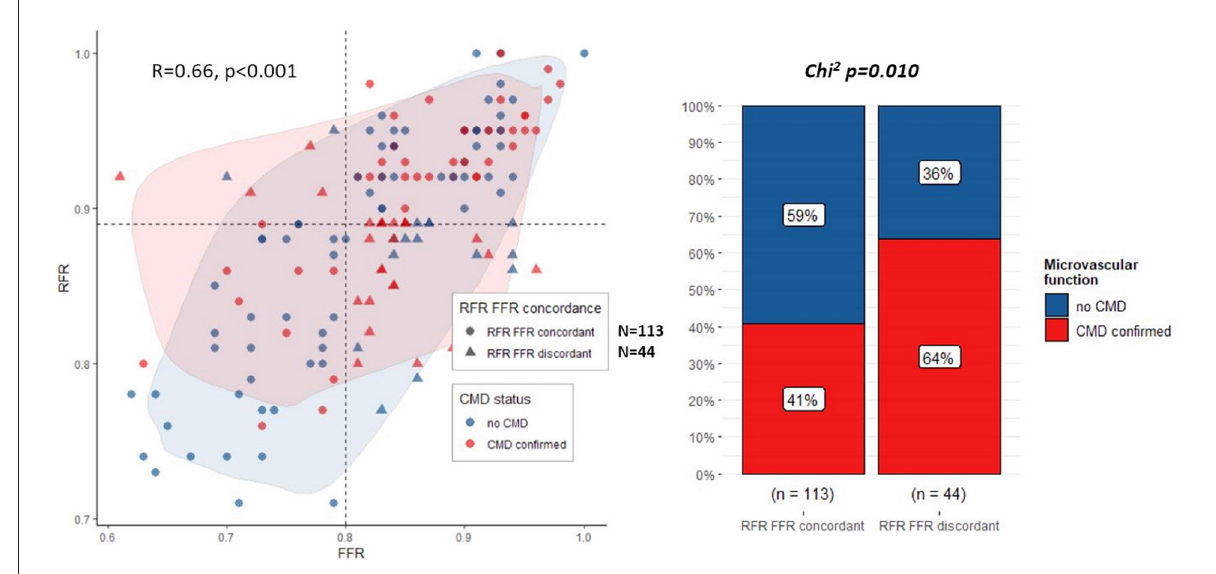
FIGURE1 Correlation between RFR and FFR (left panel) , coronary microvascular dysfunction prevalence (right panel) .